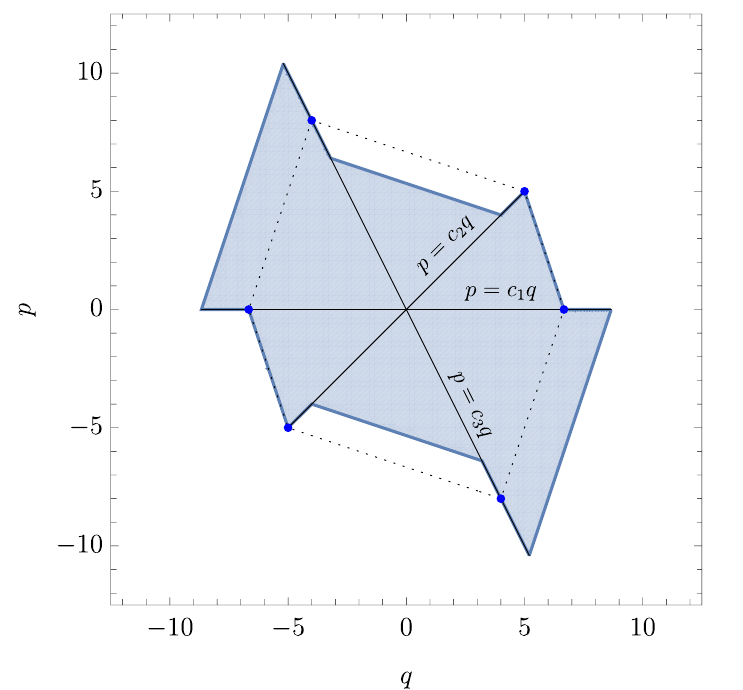
Figure 1 . An example of the phase space area for a three node quiver computed from (2.29). Here n i = (1 , − 3 , 2) , and we have exaggerated the quantum effect by taking E = 10 and i ~ = 4 . The dotted line indicates the case with i ~ = 0 . For this choice of n i ’s, we have c i = (0 , 1 , − 2) , so the polygon vertex order is ( c 3 , c 1 , c 2 ) , which is different from the quiver node order ( c 1 , c 2 , c 3 )